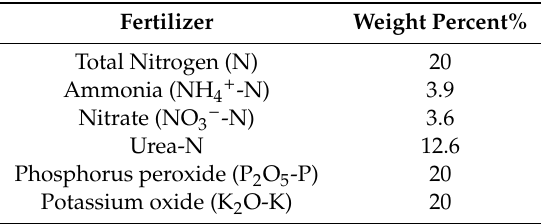
Table 2. Composition of commercial fertilizer.